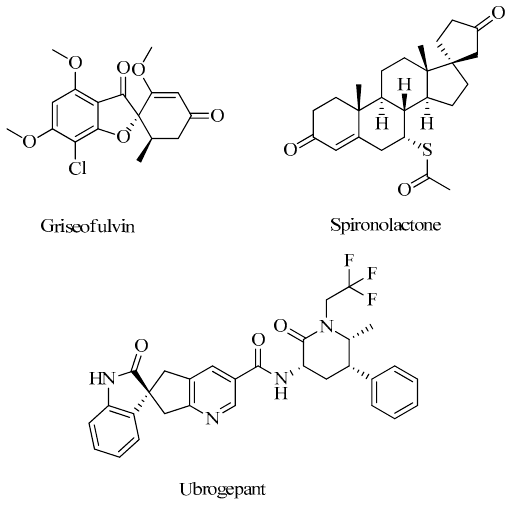
Figure 1. Drugs with spirocyclic scaffolds.